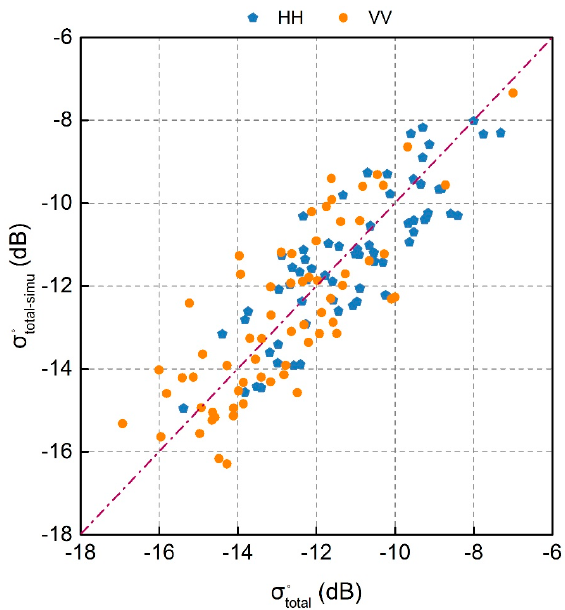
Figure 6. Scatterplot of simulated radar backscatter ( (cid:2026) (cid:3047)(cid:3042)(cid:3047)(cid:3028)(cid:3039)(cid:2879)(cid:3046)(cid:3036)(cid:3040)(cid:3048)° ) from WCM and GF-3 measured radar backscatter ( (cid:2026) (cid:3047)(cid:3042)(cid:3047)(cid:3028)(cid:3039)° ).